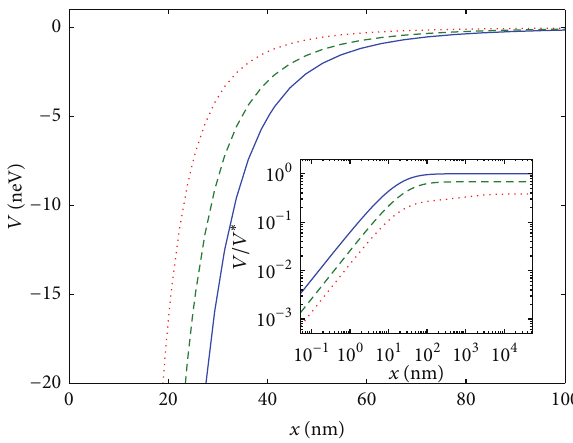
Figure 3: Casimir-Polder (CP) potential for antihydrogen in the vicinity of a material bulk; from top to bottom: perfect conductor (full line), silicon (dashed line), and silica (dotted line); inset: ratio 𝑉/𝑉 ∗ to the retarded potential 𝑉 ∗ for a perfectly conducting mirror; see